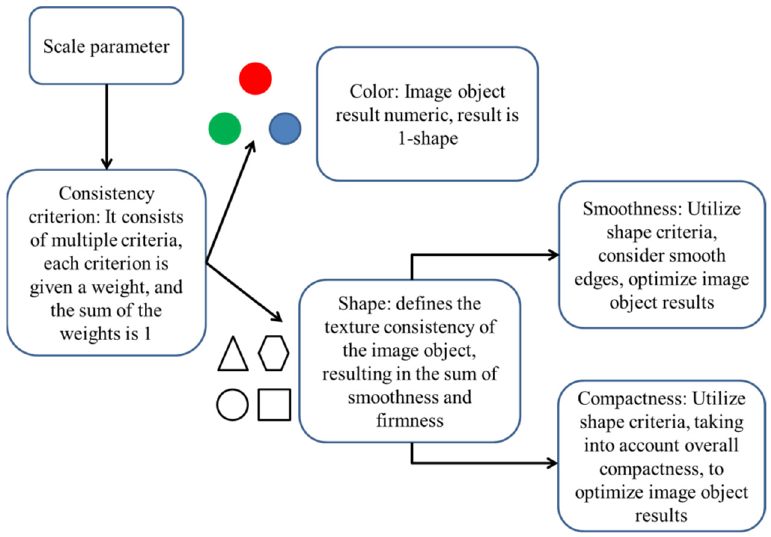
Figure 7. Main parameters of multi-scale segmentation.